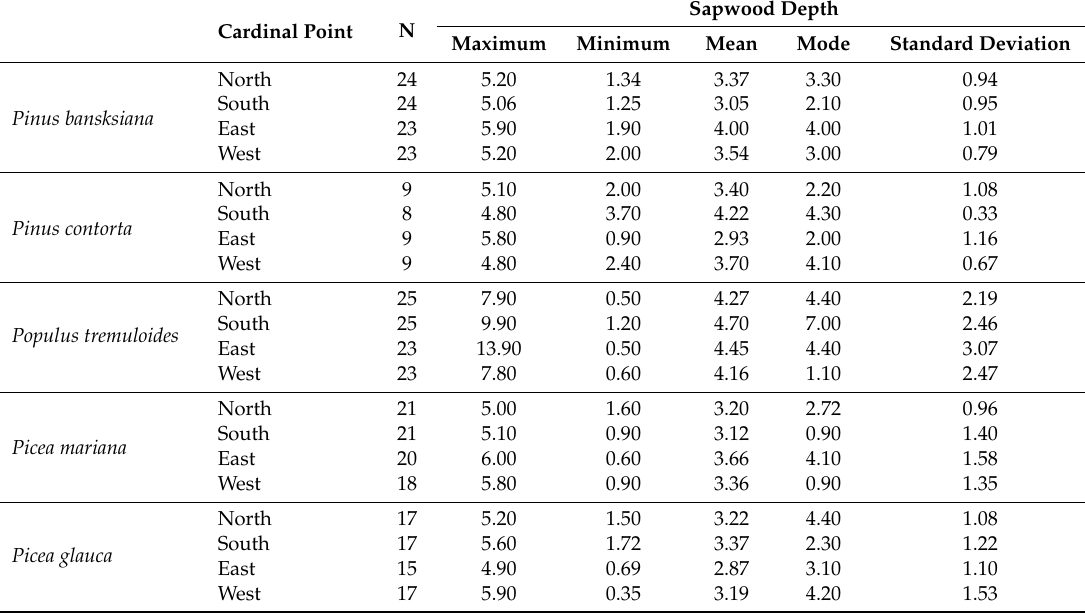
Table 1. Basic statistics of sd cp for each species sample set. N is the total number of wood cores, and statistical values are reported in centimeters